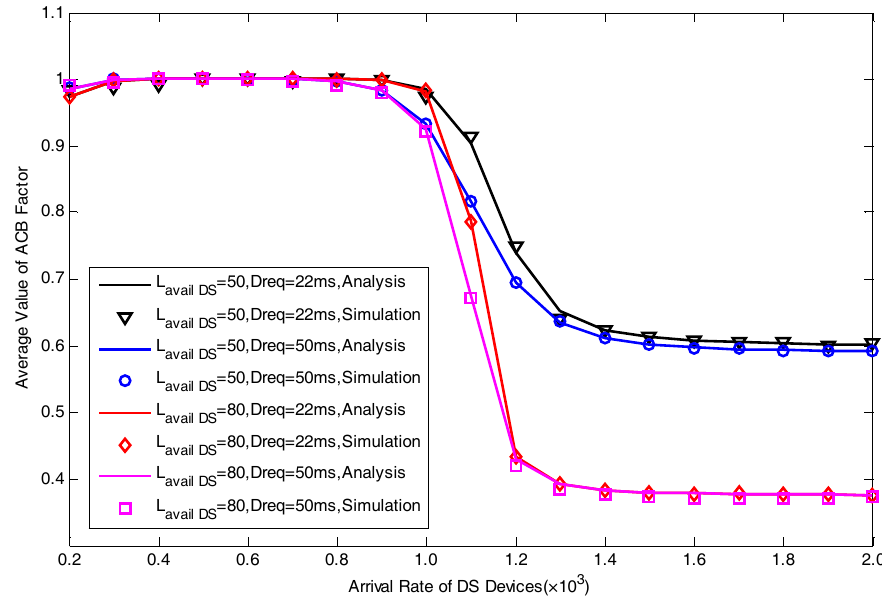
Figure 6. Average Value of ACB Factor with different L avail _ DS and D req .